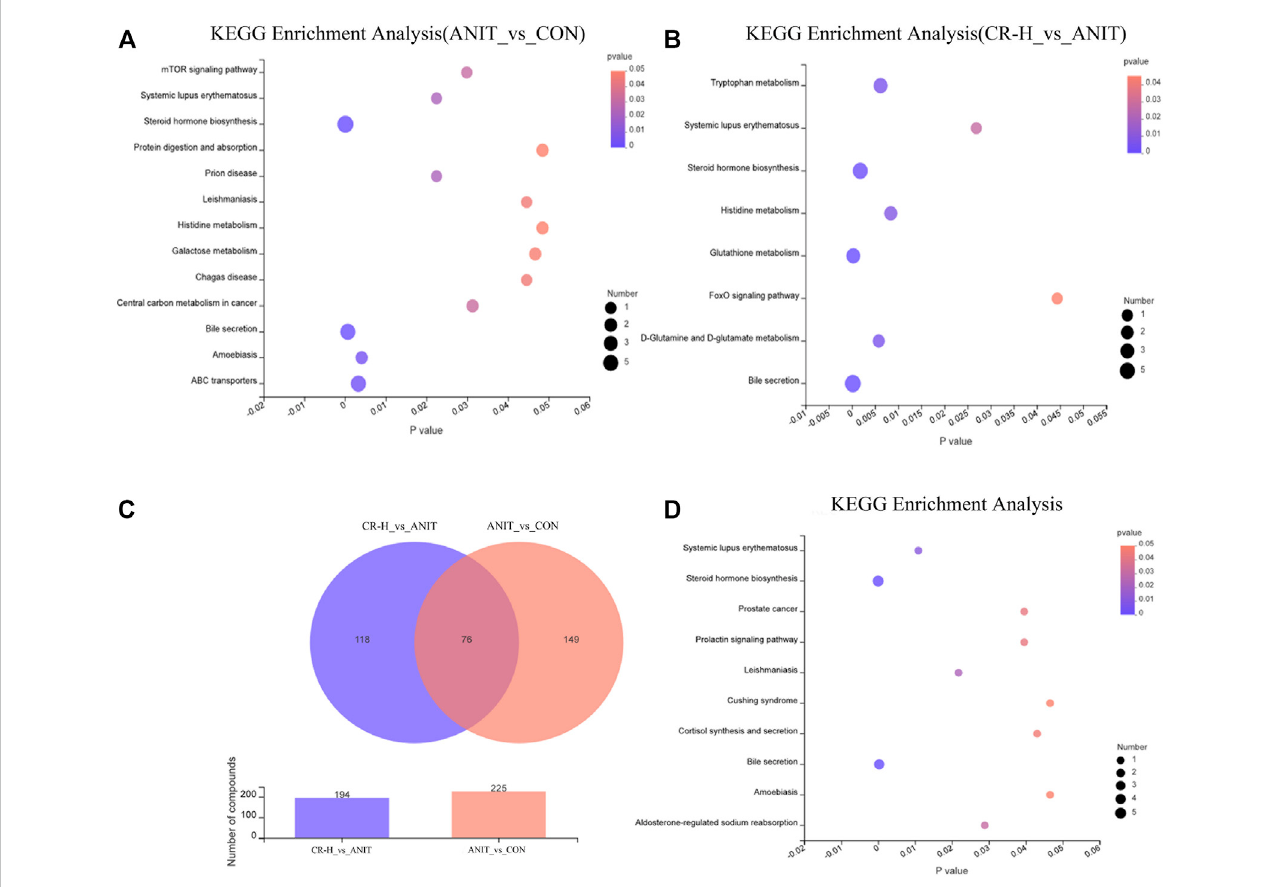
FIGURE 6 Metabolomics pathway enrichment analysis results. (A, B) KEGG pathway enrichment analysis of differential metabolites between the CON group, the ANIT group, and the CR group by bubble plot; (C) Venn diagram of differential metabolites between the groups; (D) pathway enrichment bubble map for 76 shared